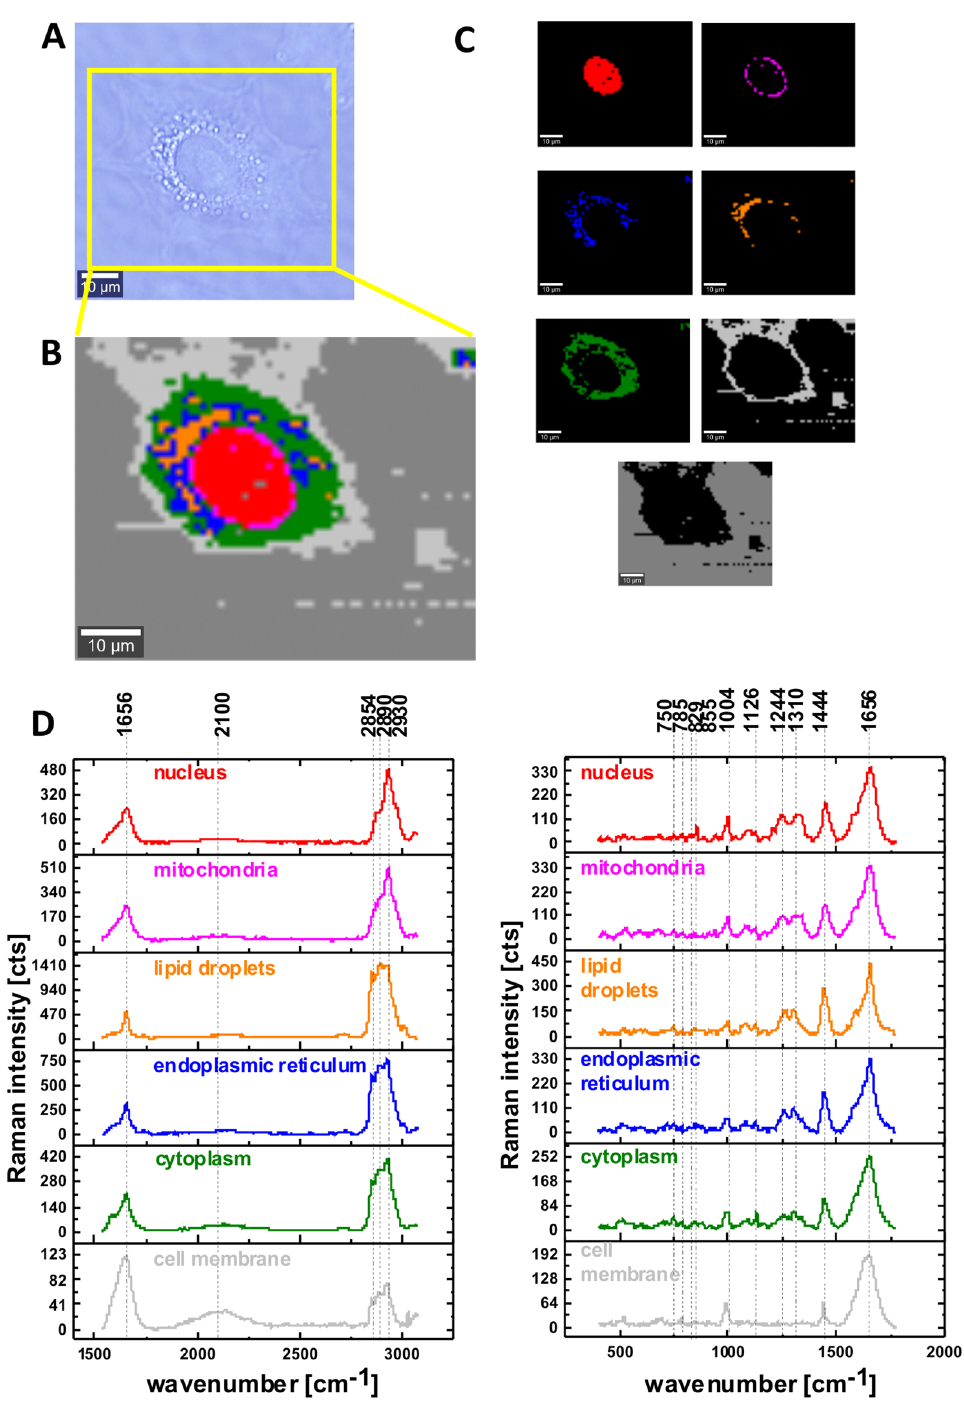
Figure 4. The microscopy image ( A ), Raman image for the area marked by yellow frame in the panel A, the size of Raman image (67 μm × 54 μm), resolution 1 μm of a typical human lung cell CCL-185 supplemented with deuterated glucose 100 mM ( B ), Raman images of separate clusters identified by Cluster Analysis method assigned to: nucleus (red), mitochondria (magenta), endoplasmic reticulum (blue) and lipid droplets (orange), cytoplasm (green), cell membrane (light grey) and cell environment (dark grey) ( C ), the average Raman spectra for all clusters for high and for low frequency region ( D ) colors of the spectra correspond to the colors of clusters; integration time 0.3 s in the high frequency region and 0.5 s in the fingerprint region, laser power